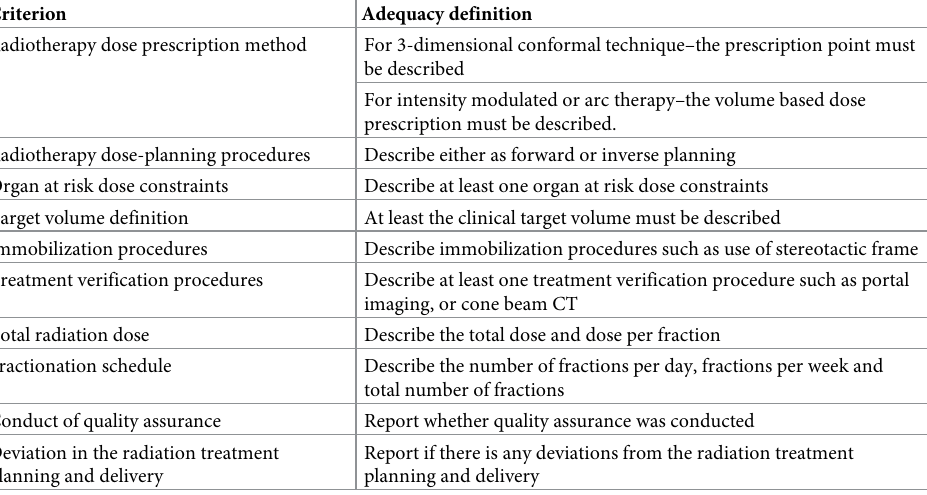
Table 1. Adequacy definition of radiotherapy reporting